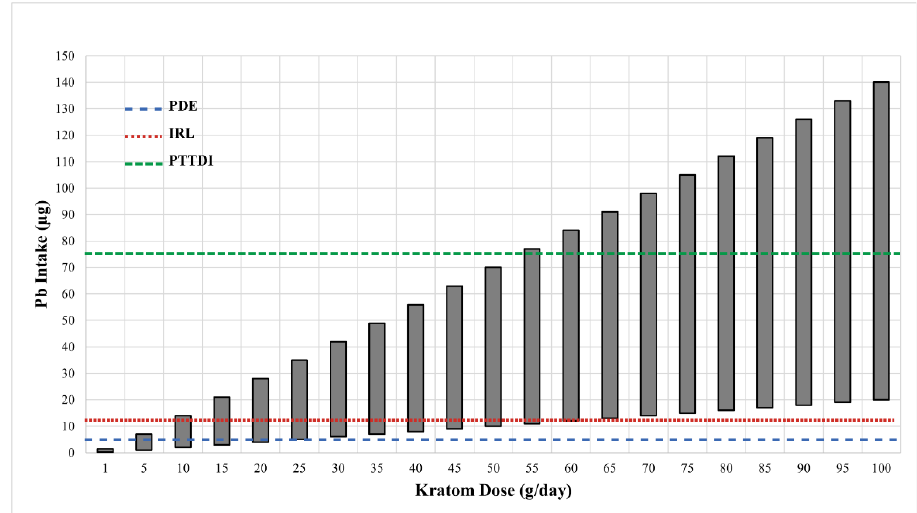
Figure 1. The estimated daily intake of Pb from various doses of kratom. Data on the ranges of Pb levels in 28 kratom products were obtained from the FDA [31]. The Pb values in those samples varied from 0.2 – 1.4 µg/g kratom. The vertical bars show the range of Pb intake at each of the kratom doses shown on the X-axis. The dotted horizontal lines show the various FDA target goals for Pb intake. The line at 75 µg represents the FDA’s provisional tolerant total daily intake (PTTDI) from food. The line at 12.5 µg represents the FDA’ s interim reference level (IRL) from food, and the line at 5 µg represents the permitted daily exposure (PDE) from pharmaceuticals.